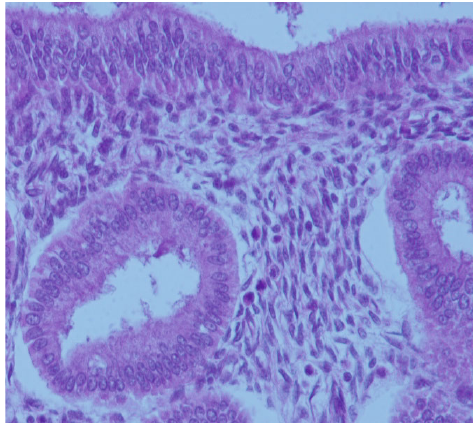
Figure 6: Endometrial glands and stroma (H&E, 40x).